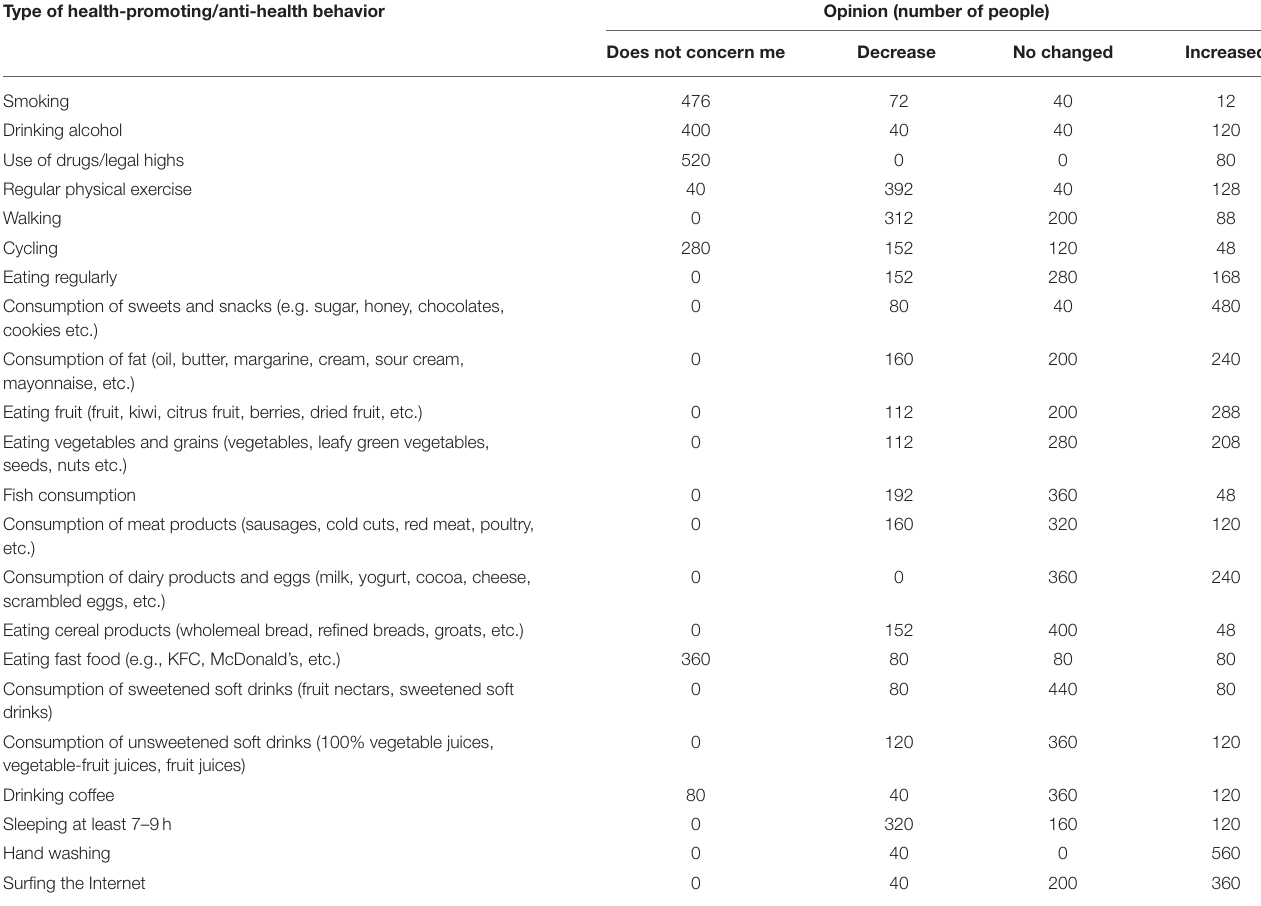
TABLE 3 | Respondents’ views on changes in health-promoting and anti-health behavior during the pandemic. Type of health-promoting/anti-health behavior Opinion (number of